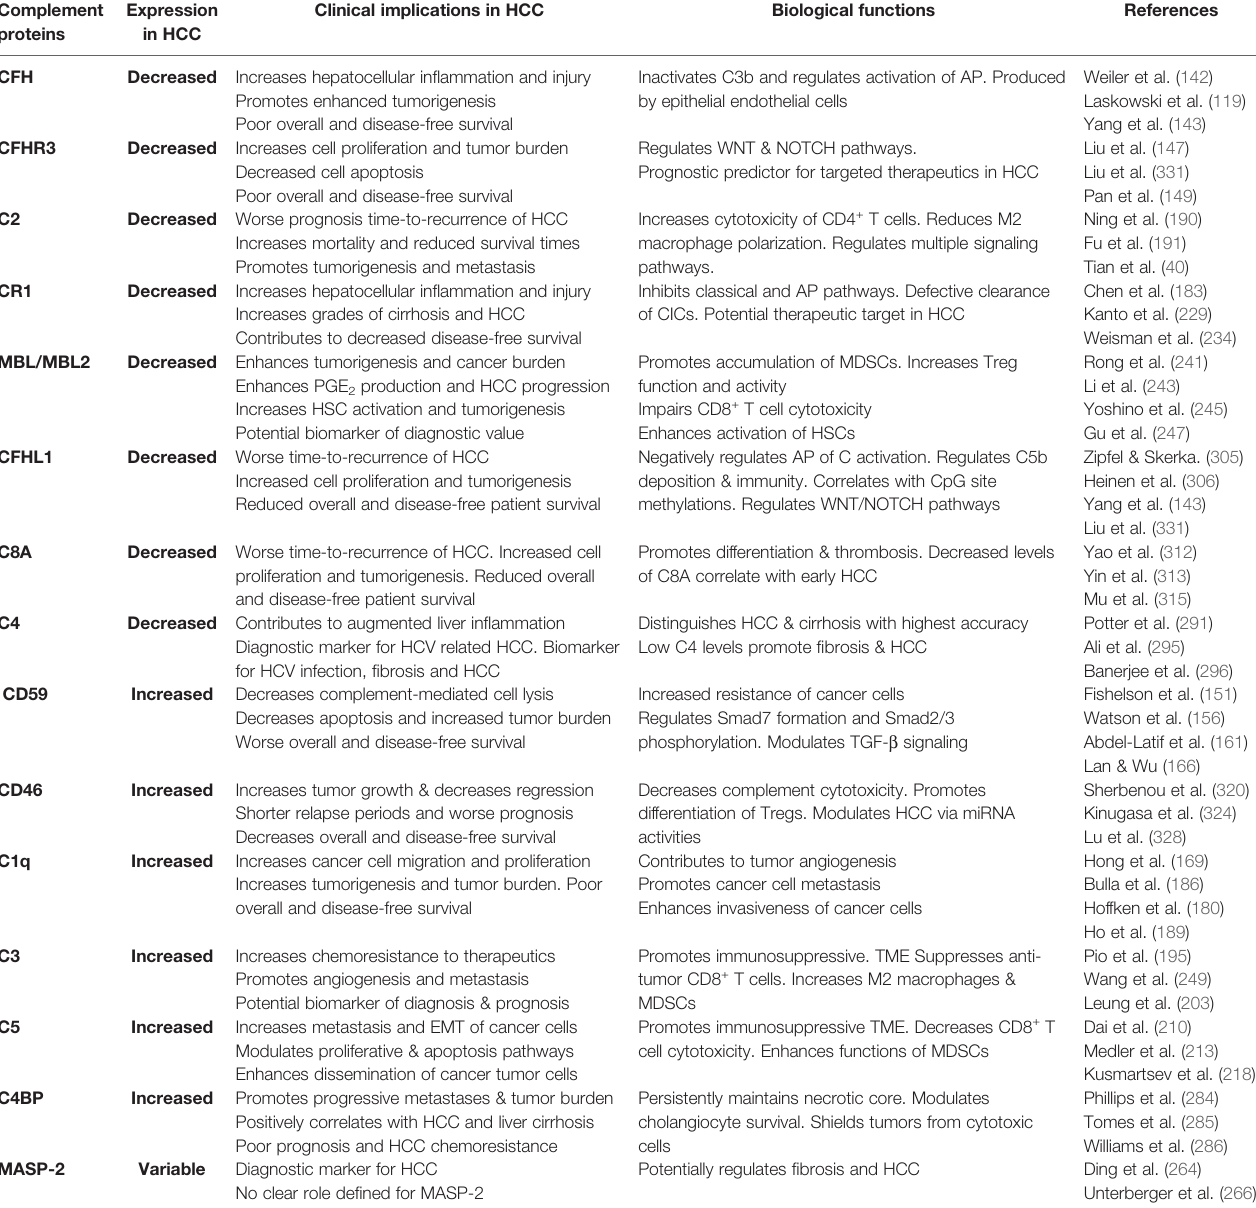
TABLE 3 | Summary of clinical and biological roles of complement proteins in hepatocellular carcinoma